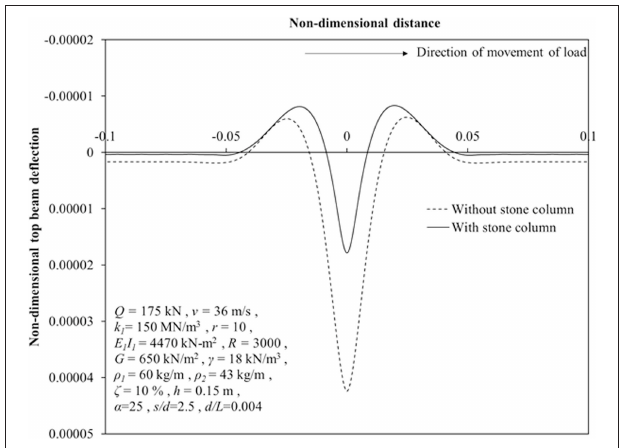
FIGURE 4 | Deflection of top beam: the effect of stone column inclusion.